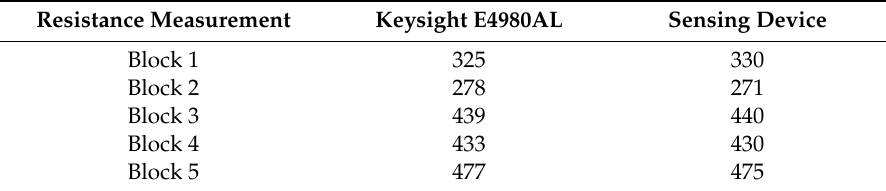
Table 1. Experiment 1 resistance measurement results in Ω .